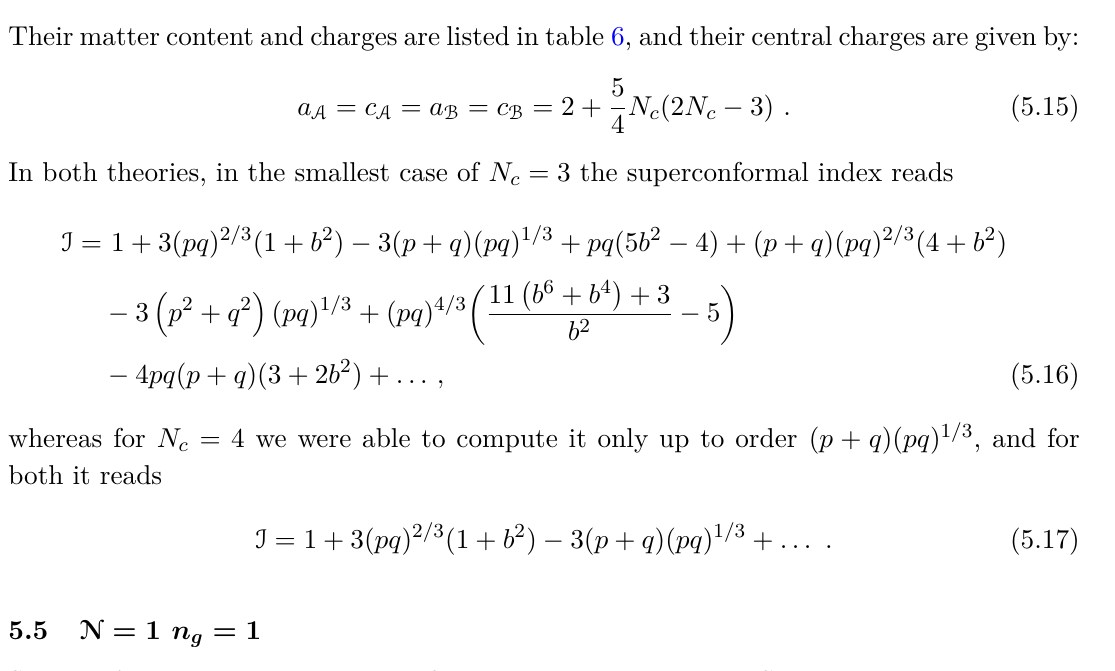
J 3 + 1 T , so that all matter fields have N = 1 3 3